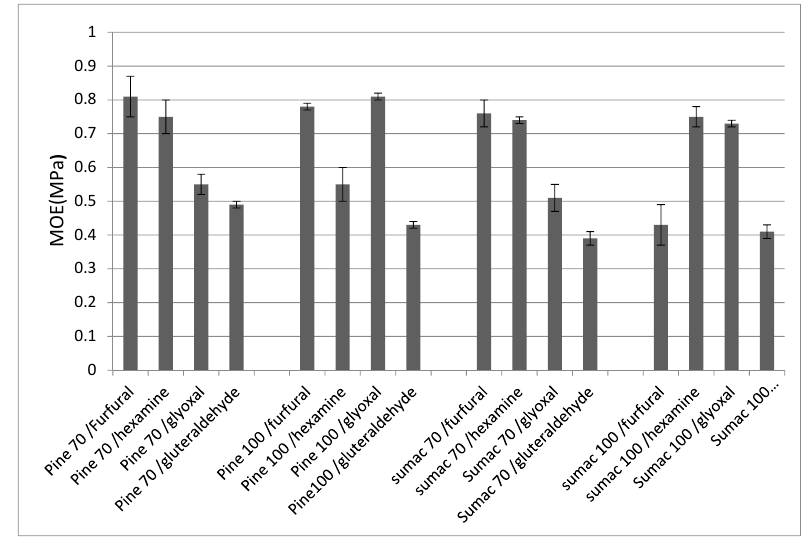
Figure 5. Internal bond strength (IB) of tannins-based particleboards. 70 and 100 refer to the extraction tempature of the tannins.